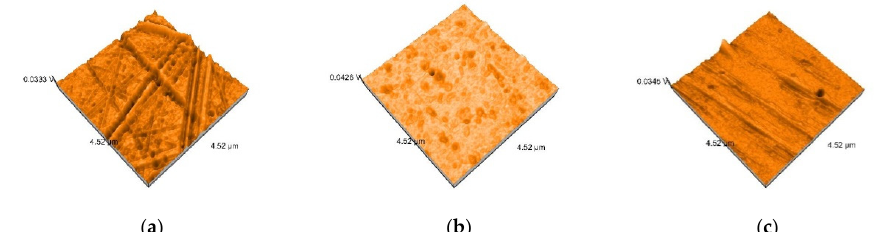
Figure 10. 3D atomic force microscopy (AFM) images of the samples before thermoforming: ( a ) S; ( b ) D; ( c ) B.